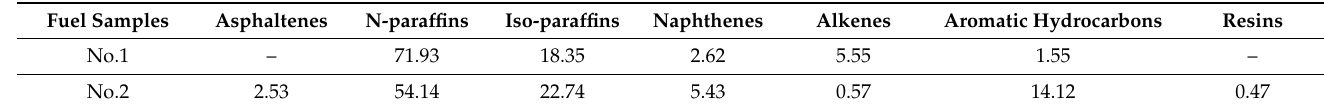
Table 5. The group hydrocarbon composition of oil products No.1 and 2 (% wt.).